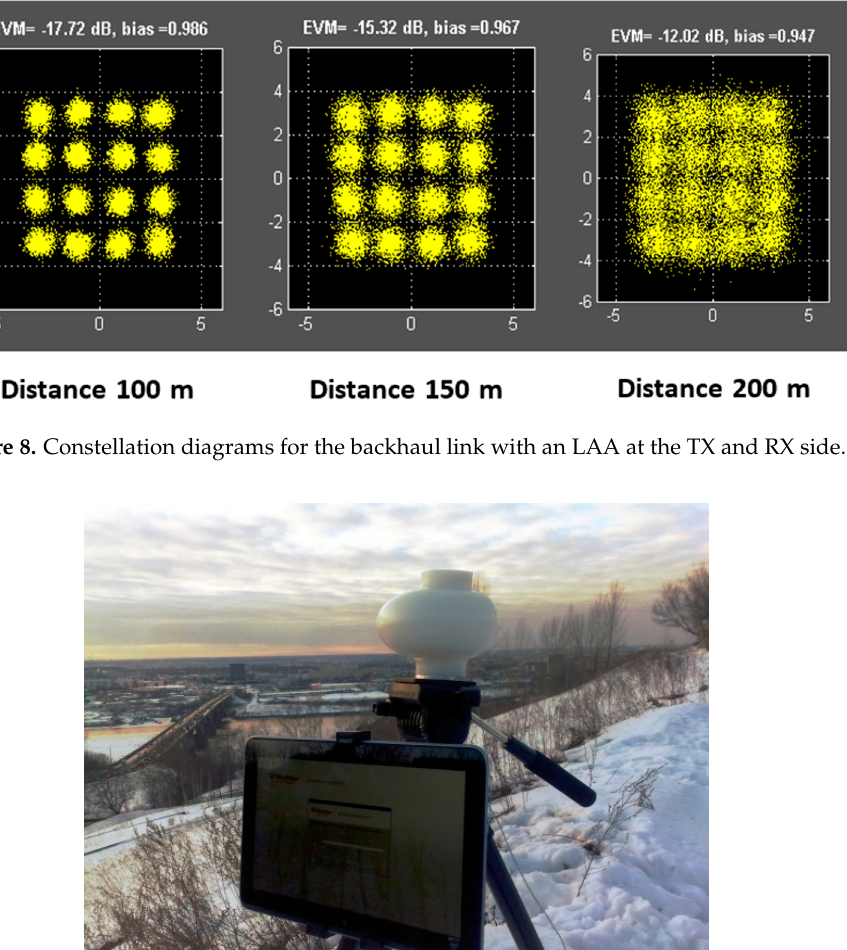
Figure 9. LAA prototype link in the field trial.